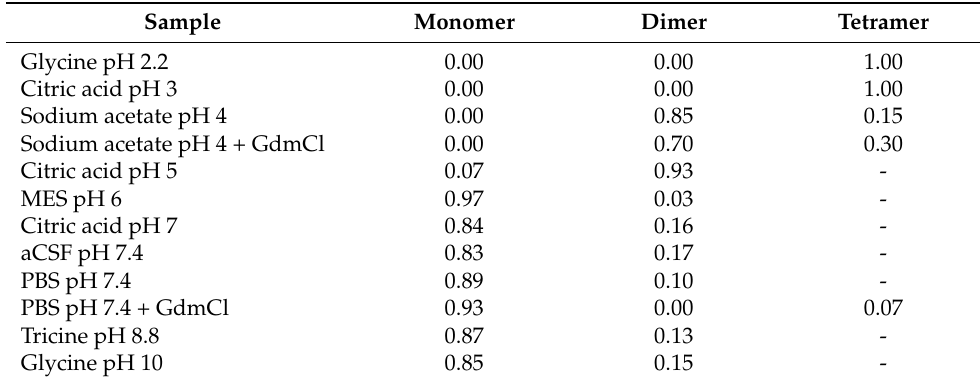
Table 3. The fractions of oligomeric forms of HCC calculated from SAXS data. Sample